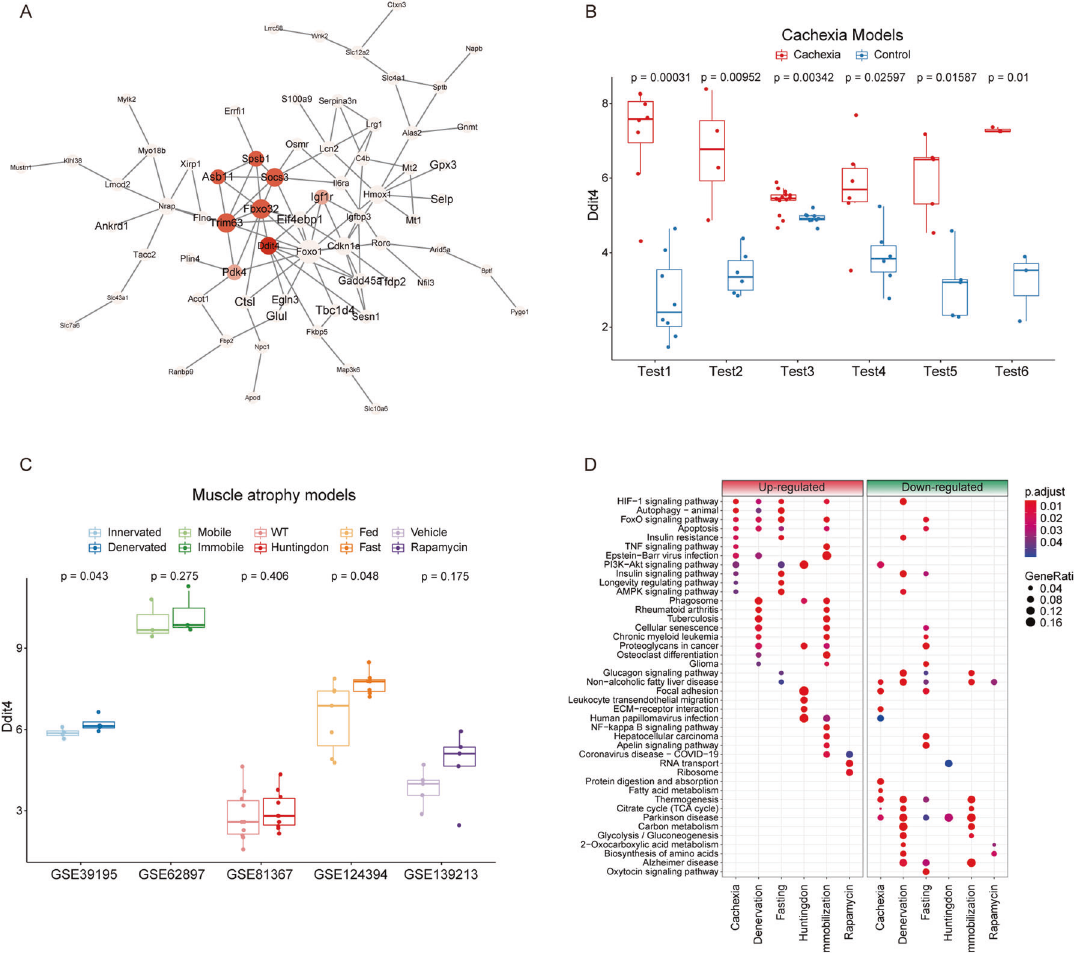
Fig. 6 The protein interaction network revealed Ddit4 as a key protein in cancer cachexia. A The protein-protein interaction (PPI) network of upregulated genes in the enriched KEGG pathways was constructed according to their biological association. The color of the node indicates the degree of the gene, and the circle and font size of the node indicates the number of direct edges. B The expression of Ddit4 in each cachexia model. C The expression of Ddit4 in other muscle atrophy models such as denervated, fasting, immobilization, Huntingdon disease, and rapamycin-treated mice. D All enriched pathways of upregulated and downregulated genes in cachexia and degenerative conditions such as fasting and denervation were